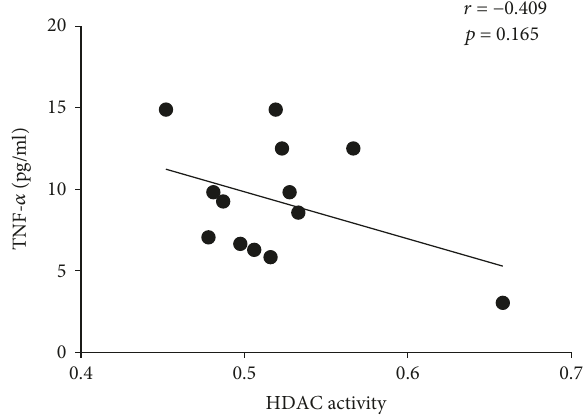
Figure 8: The correlation about TNF- α expression and HDAC activity in RA